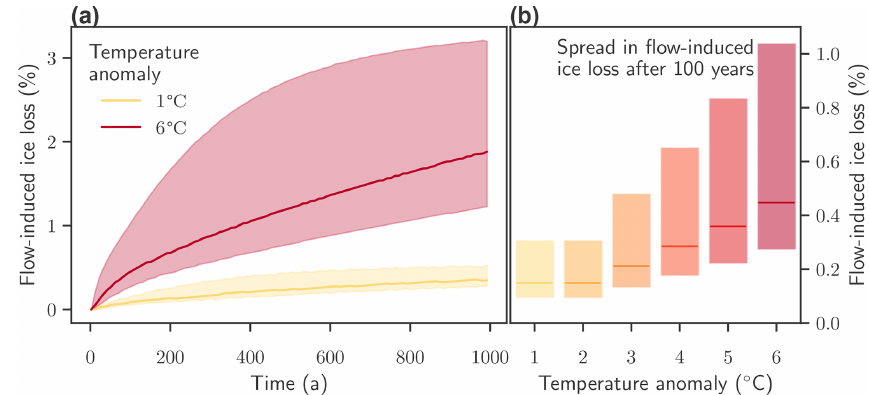
Figure 8. Effect of temperature forcing and activation energy on flow-driven ice. (a) Time evolution of ice loss under warming of 1 ◦ C and 6 ◦ C. For warming of (cid:49)T = 1 ◦ C the conceptual ice sheet loses 0.35% of ice after 1000 years for standard parameters (solid yellow line). Variations in the activation energies Q lead to variations in ice loss on the same order of magnitude (shaded area). For a warming of (cid:49)T = 6 ◦ C the conceptual ice sheet loses 1.89% of ice after 1000 years for standard parameters (solid red line). The variations in ice loss due to different parameters for the activation energy Q (shaded area) are strongly asymmetrical and, in particular during the first 300 years, high compared to the total amount of ice loss. (b) Uncertainty in flow-induced ice loss after 100 years of simulation time over all combinations of Q w and Q c , and temperature anomalies (cid:49)T . The flow exponent n = 3 is kept fixed for all simulations.